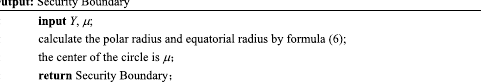
Algorithm 3. Security Boundary Model.